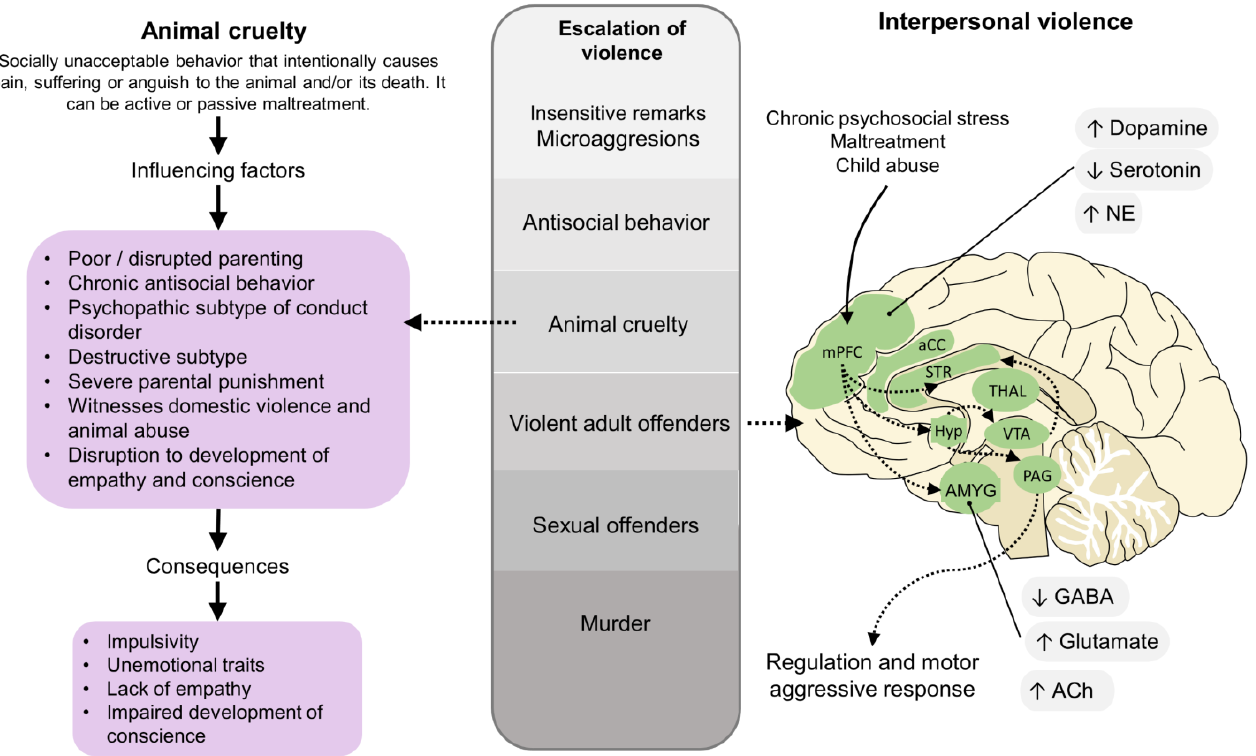
Figure 3. The origin of childhood animal abuse and the development of interpersonal aggression. aCC: anterior cingulate cortex; Ach: acetylcholine; AMYG: amygdala; Hyp: hypothalamus; mPFC: medial prefrontal cortex; NE: norepinephrine; PAG: periaqueductal gray; STR: striatum; THAL: thalamus.